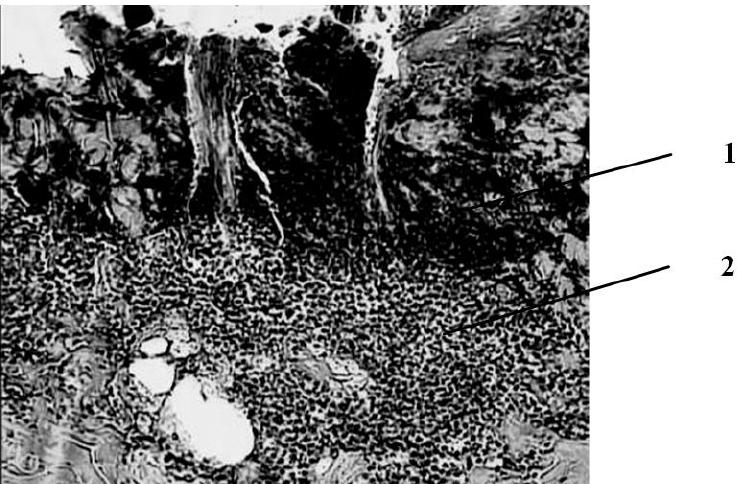
Figure 3. Histological picture of the wound seven days after the application of the burn during treatment with ozonated oil. The scab is infiltrated in places by segmented leukocytes; clusters of microbial colonies are visible in it. Purulent exudate is determined under the scab. In the necrotic dermis—microabsesses. 1—scab. 2—purulent exudate. Stained with hematoxylin and eosin. magn. ×200.